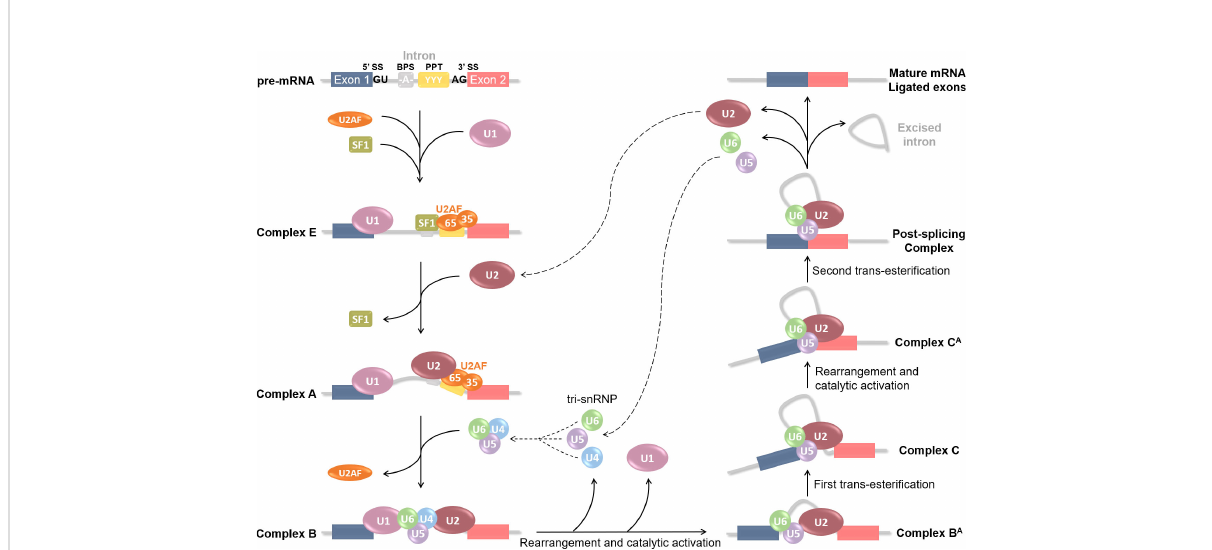
FIGURE 2 Step-by-step spliceosome assembly and pre-mRNA splicing reaction. Splicing is catalyzed by a large protein complex called the spliceosome. Spliceosome assembly requires a series of steps and intermediate complexes, and starts at the transcription site. It involves 5 small nuclear ribonucleoprotein particles (snRNPs): U1, U2, U4, U5 and U6; combined with roughly 300 associated proteins. Splicing is based on the recognition of 5 ’ SS and 3 ’ SS (splicing sites), also known as donor or acceptor sites, located at each end of an intron. Several cis-acting regulatory sequences are necessary such as the branching point sequence (BPS) and the poly-pyrimidine tract (PPT). Splicing begins with U1 snRNP recognition of the 5 ’ SS and binding onto the pre-mRNA. U2 auxiliary factor (U2AF) 65 and 35kDa sub-units then respectively bind the PPT and the 3 ’ SS; and Splicing Factor 1 (SF1) the BPS. These fi rst steps form the E(arly) complex, which converts into pre-spliceosome complex A after U2 snRNP recruitment at the BPS and SF1 replacement. U2AF then leaves and U4, U5 and U6 pre-assemble into the tri-snRNP which is recruited to compose the pre-catalytic complex B. Rearrangement and catalytic activation into complex B A occur via U1 and U4 release. A fi rst trans-esteri fi cation reaction is catalyzed and leads to the Complex C containing free Exon 1 and Intron-Exon 2 fragment. The complex undergoes additional rearrangement and activation, and the Complex C A catalyzes the second trans-esteri fi cation reaction to free Exon 2. Both exons are ligated in the Post-splicing Complex; U2, U5 and U6 as well as excised intron are released; and mature mRNA is formed. All snRNPs are recycled for additional rounds of